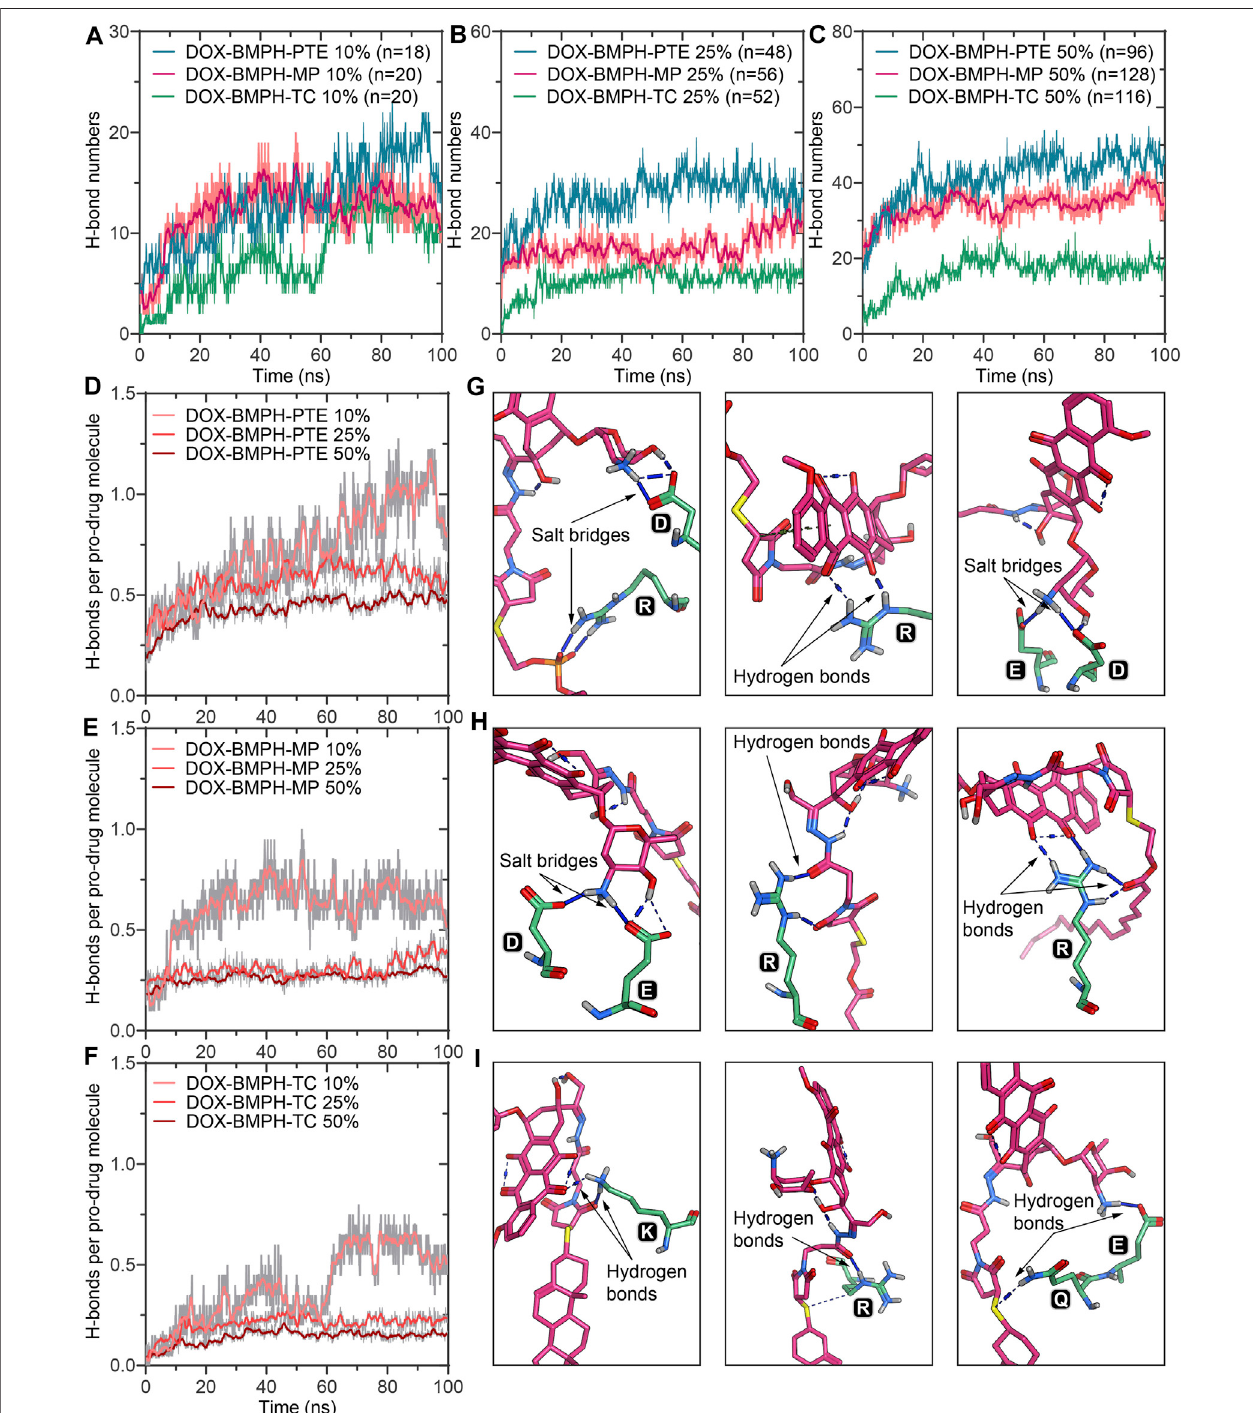
FIGURE 5 | A schematic illustration of the ND formulation designs for free DOX and lipidated DOX-prodrugs.